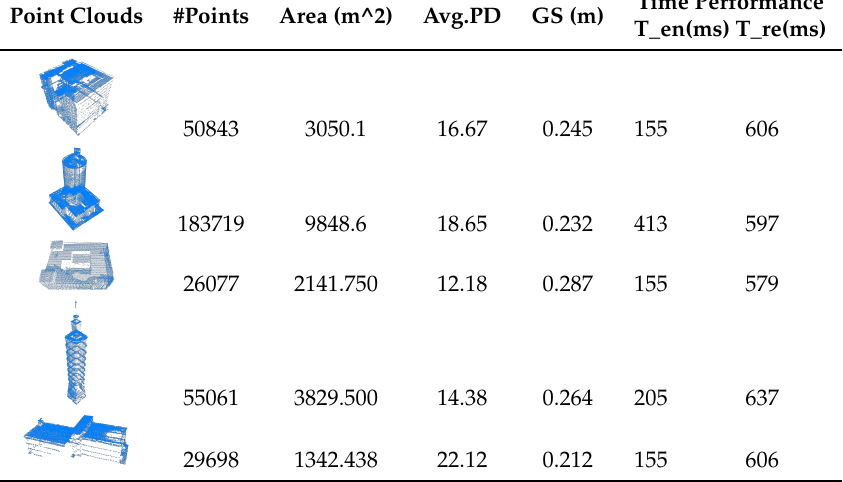
Table 1. Time performance. 1st column: point clouds of the tested building; 2nd column: number of points; 3rd column: ground area of a building; 4th column: average point density; 5th